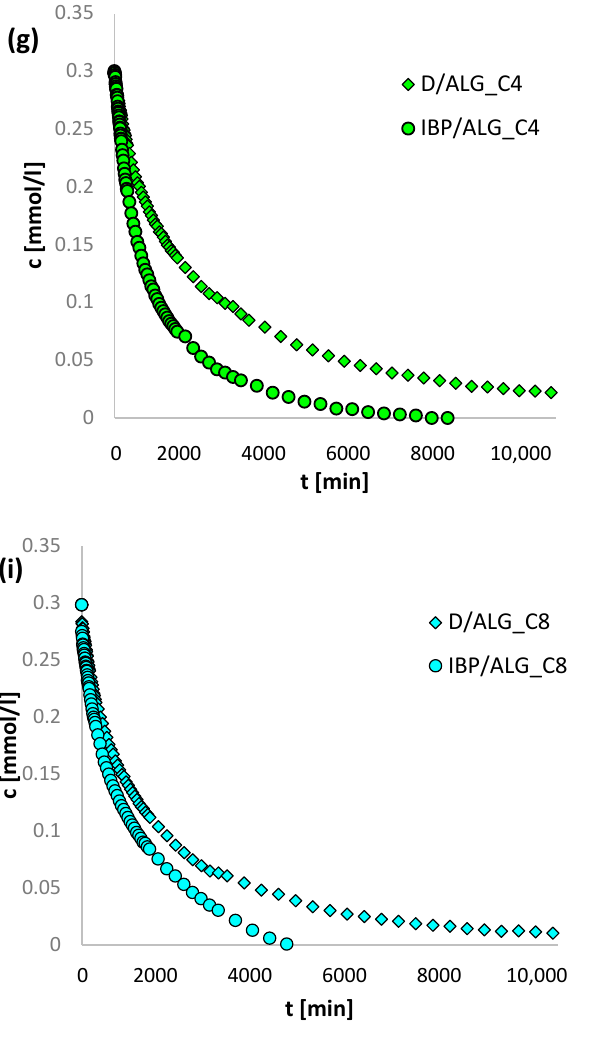
Figure 5. Comparison of adsorption kinetic for IBP and D on ALG_C2, ALG_C4 and ALG_C8 presented as changes in concentration ( a , c , e , g , i ) and adsorption ( b , d , f , h , j ) over time.